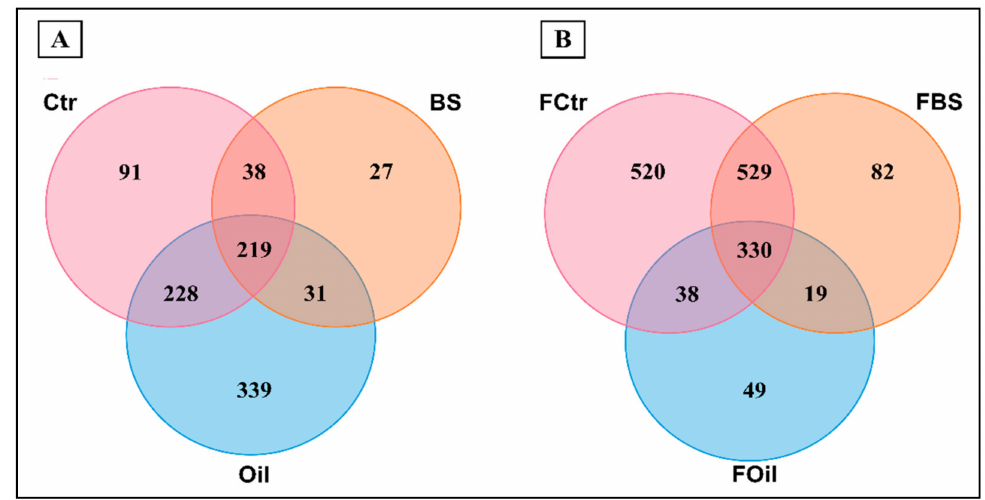
Figure 2. Venn diagram representing operational taxonomic units (OTUs) shared between treatments (Ctr, control; BS, nutrient amendment; Oil, diesel oil) at ( A ) 4 ◦ C and ( B ) under the FTC regime. Table 2. SIMPER results for tested treatments showing the first 10 taxa that most contributed to principal coordinate analysis (PCoA)